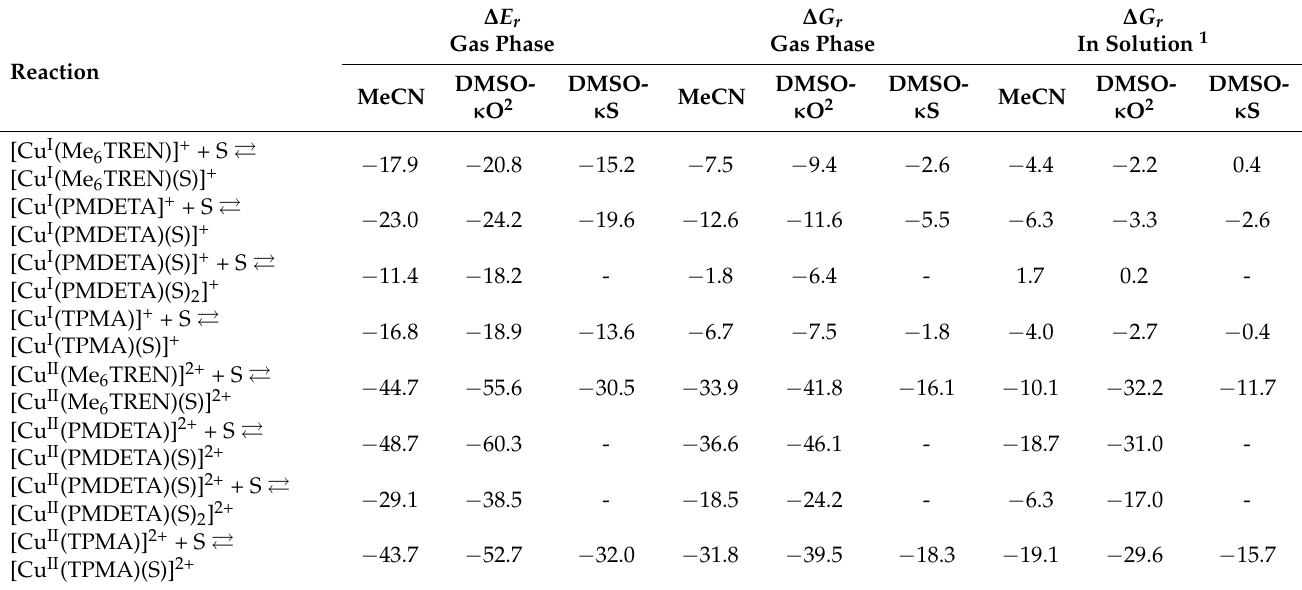
Table 4. ∆ E r and ∆ G r (kcal/mol) of reaction (1) calculated in gas phase and in solution; level of theory: